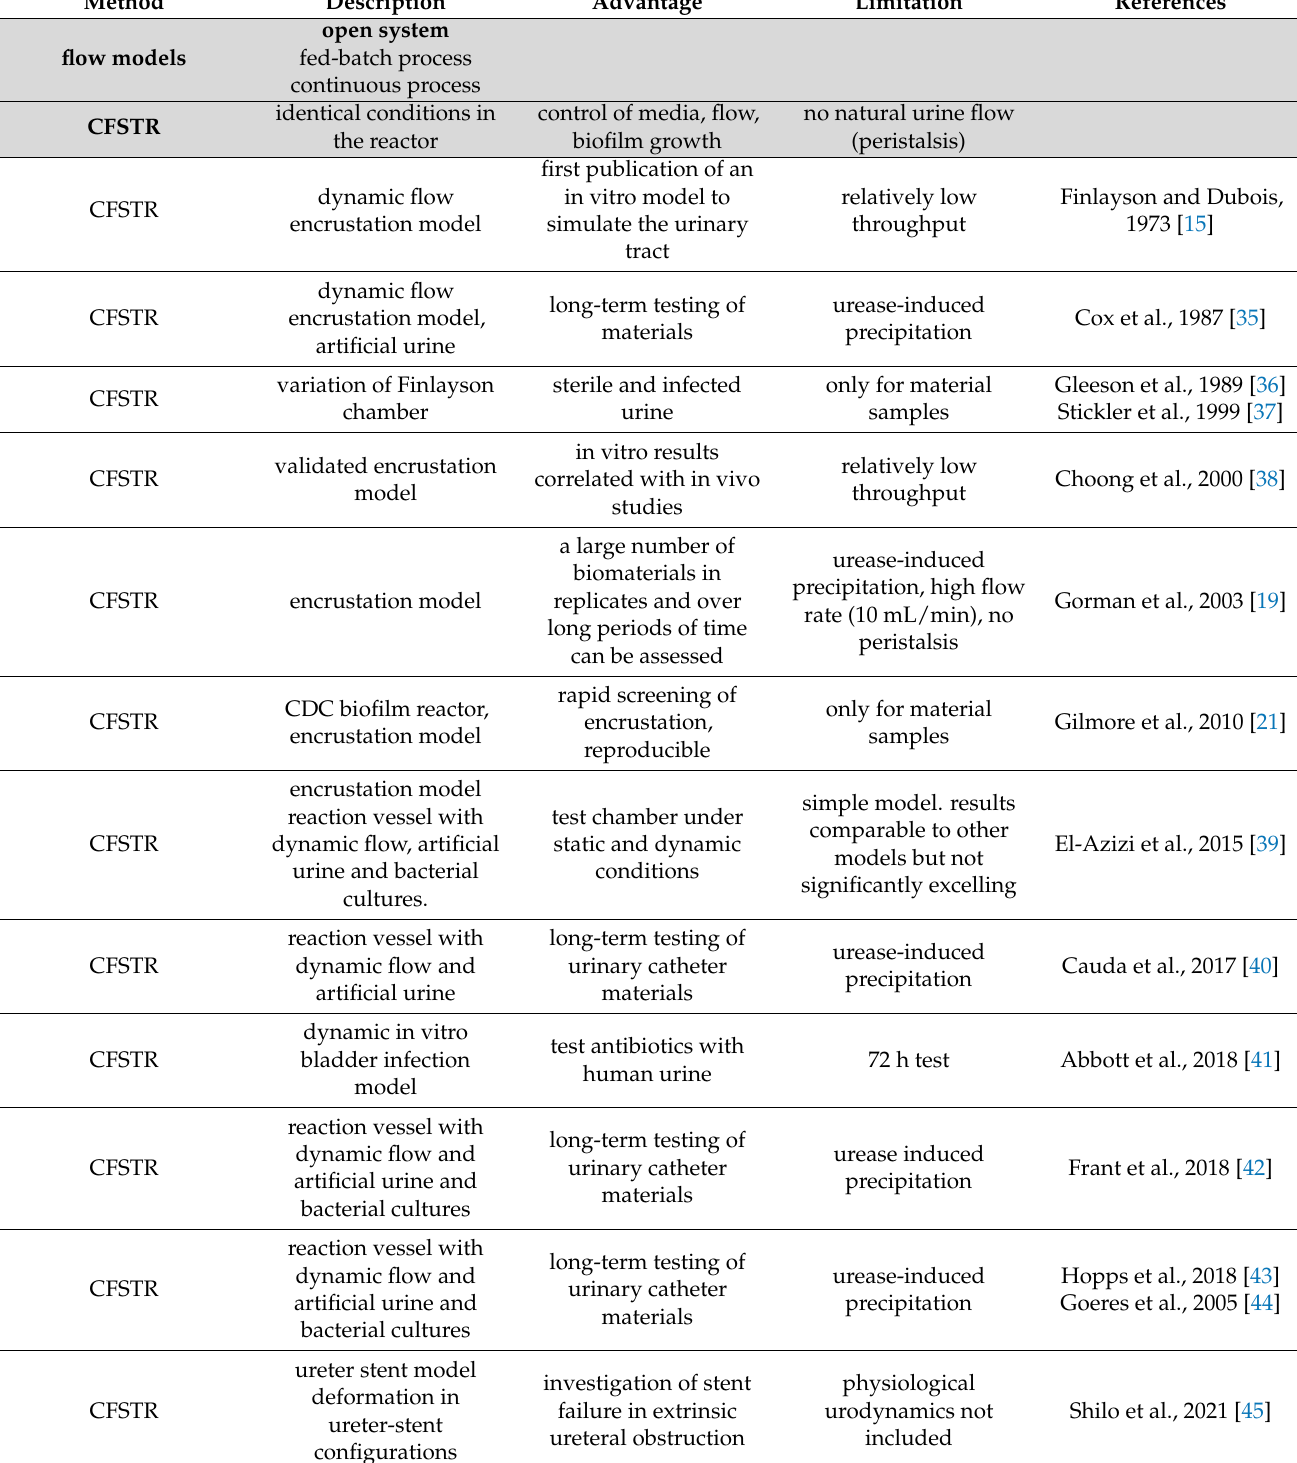
Table 1. Selected in vitro models for the investigation of encrustations and biofilms on urological